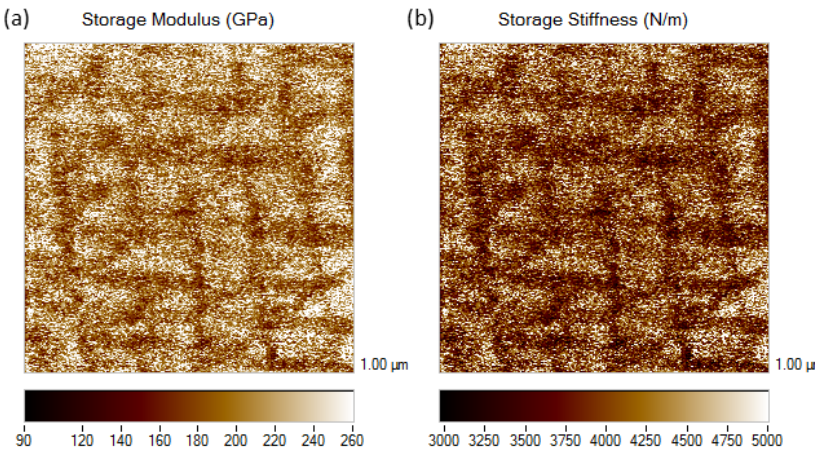
Figure 6. Nano-scale elastic properties of the studied Fe-Al-Ti superalloy detected by Hysitron nanoDMA (nano-scale dynamical mechanical analysis)